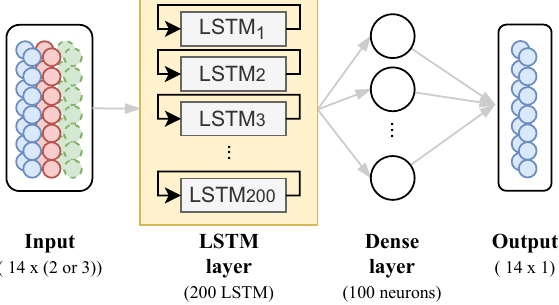
Figure 6. Neural Network Architecture